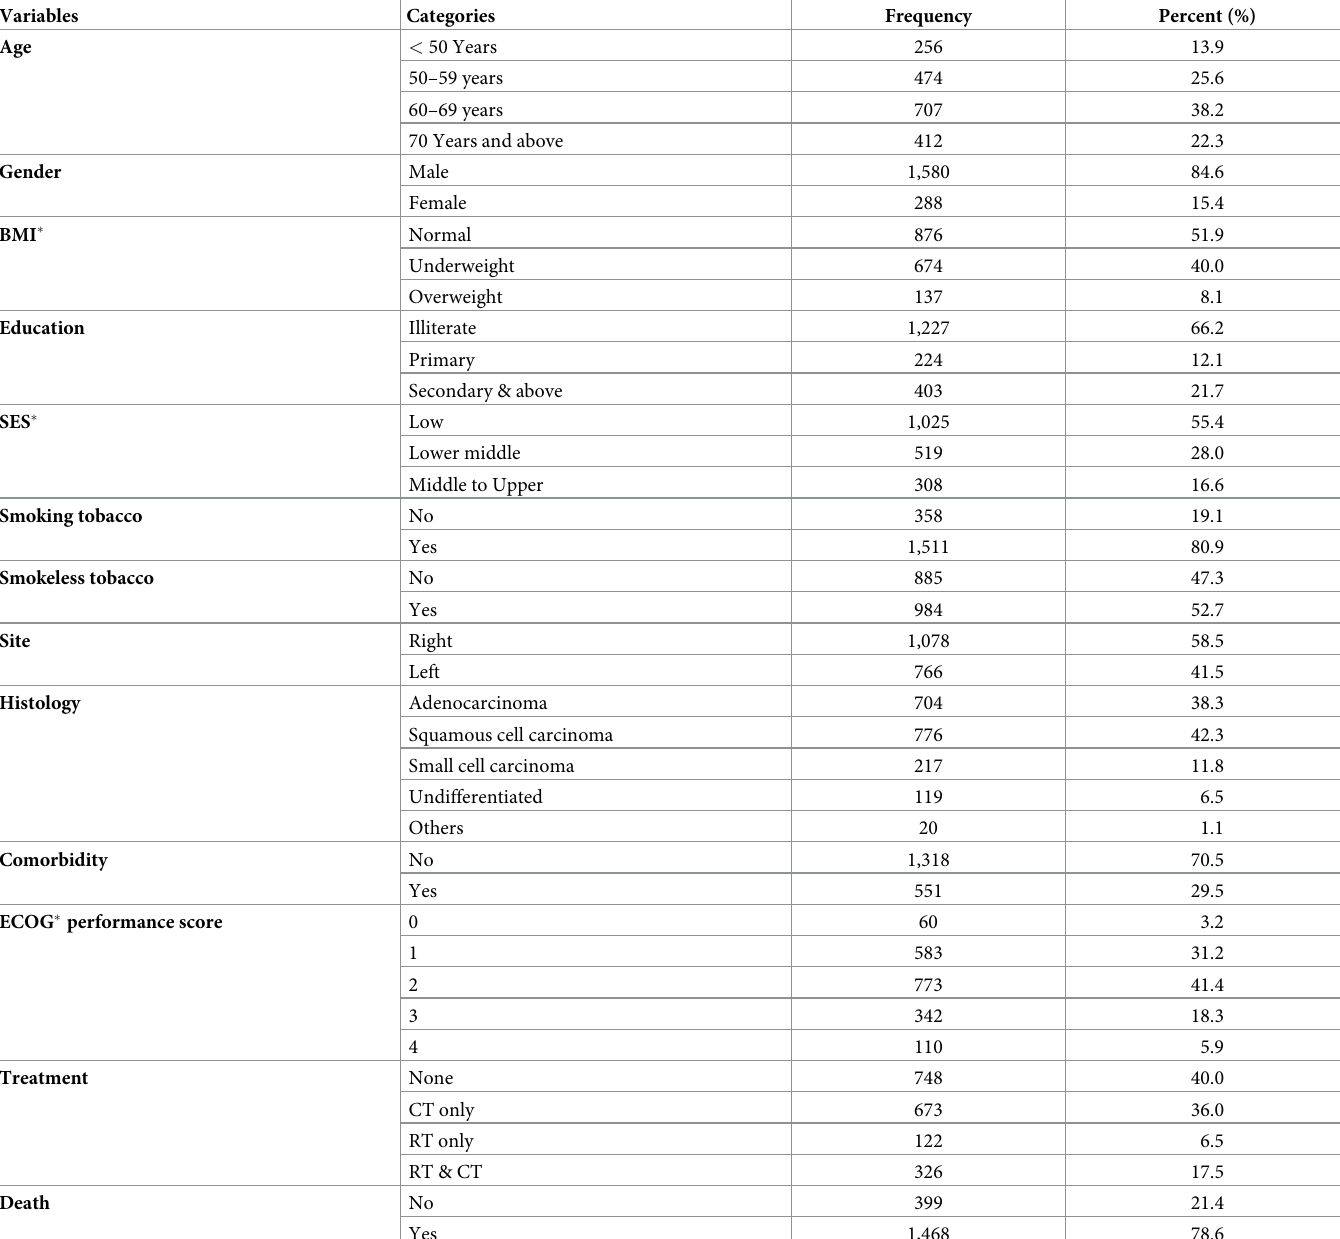
Table 1. Characteristics of demographic and clinic-pathologic